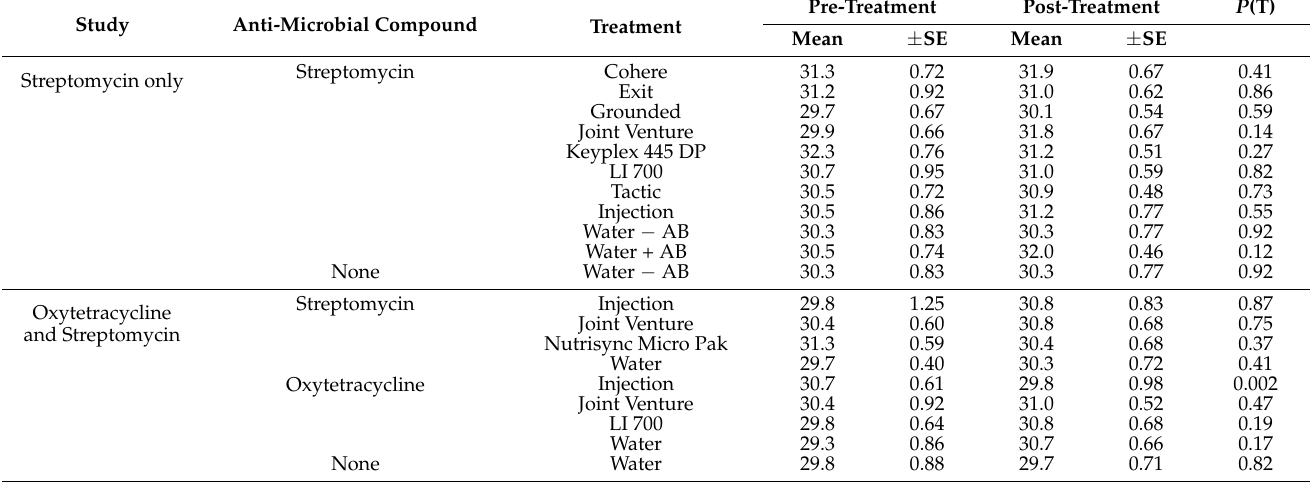
Table 2. Cycle threshold values for detection of ‘ Candidatus Liberibacter asiaticus’ DNA in leaves of ‘Hamlin’ sweet orange ( C. × sinensis ) before and after foliar application or trunk injection of two different adjuvant studies. P (T) represents a two-tailed paired t -test. Post-treatment sampling was 1 month after application.